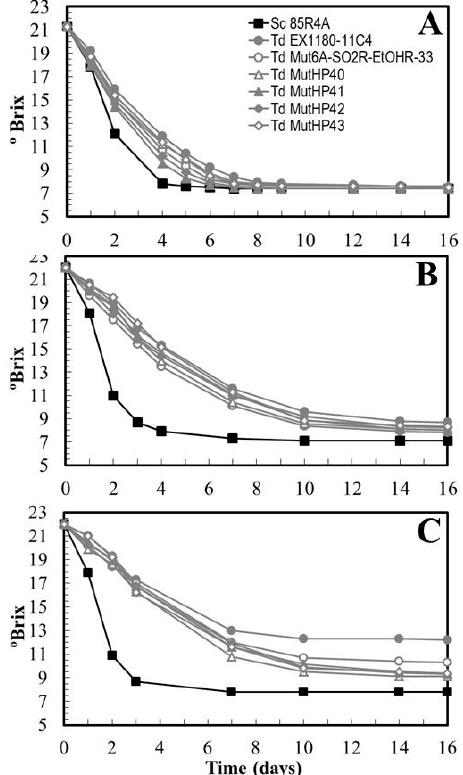
Figure 5. Fermentation kinetics of some T. delbrueckii high CO 2 pressure resistant (HP R ) mutants inoculated in sterile fresh grape must ( A ), synthetic must ( B ), and synthetic must supplemented with 100 mg / L SO 2 ( C ). Data are the mean values of three fermentations inoculated with each yeast strain. Standard deviations were less than 11% of the means. The degree of dominance throughout fermentation of each inoculated yeast strain was 100%.